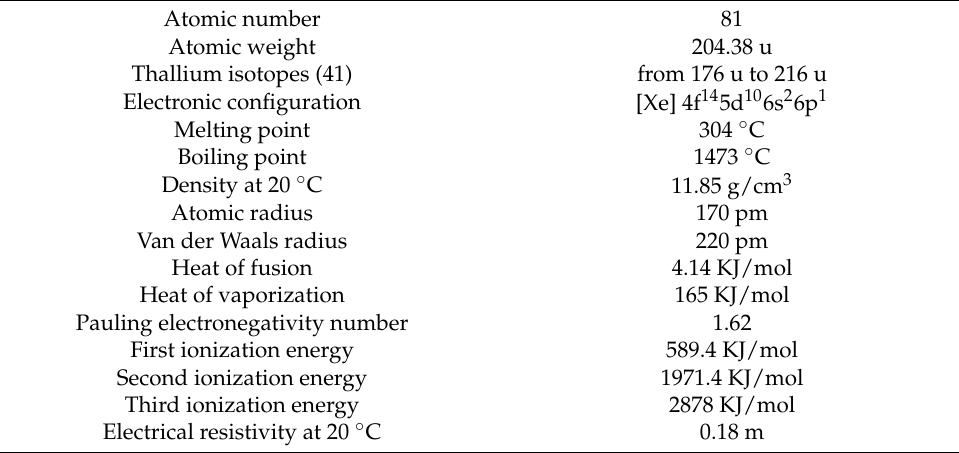
Table 1. Physical and chemical properties of thallium